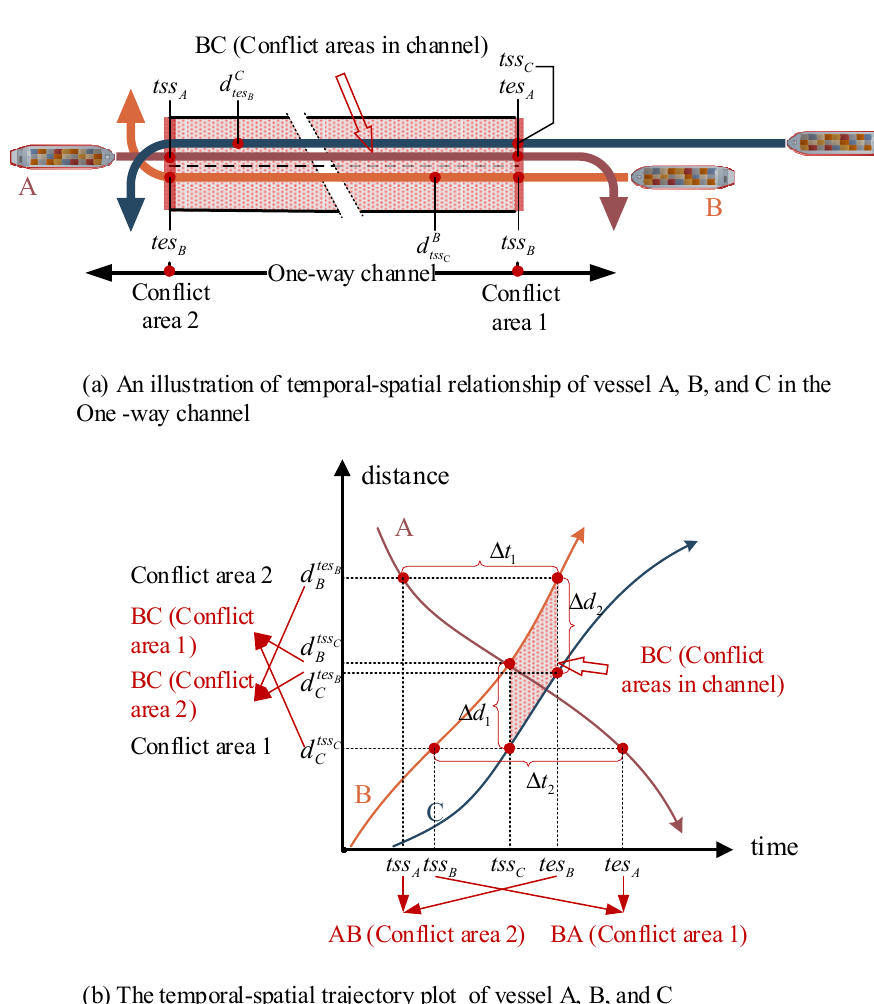
Figure 6. An illustration of vessels navigating with variable speed in a one-way channel. The speed of the vessel can be expressed at any